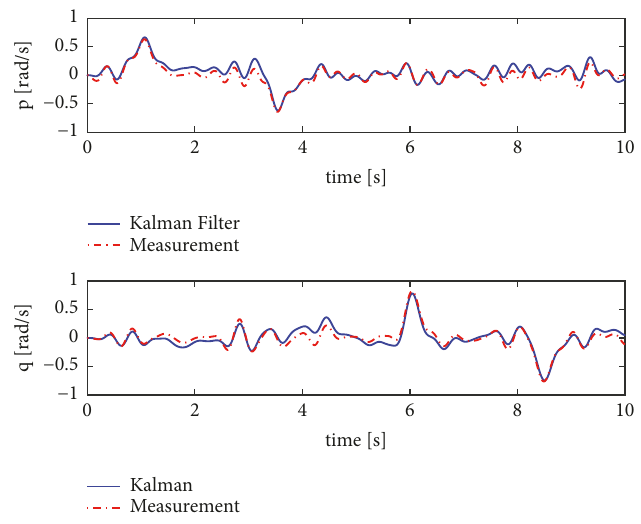
Figure 13: Performance of the Kalman